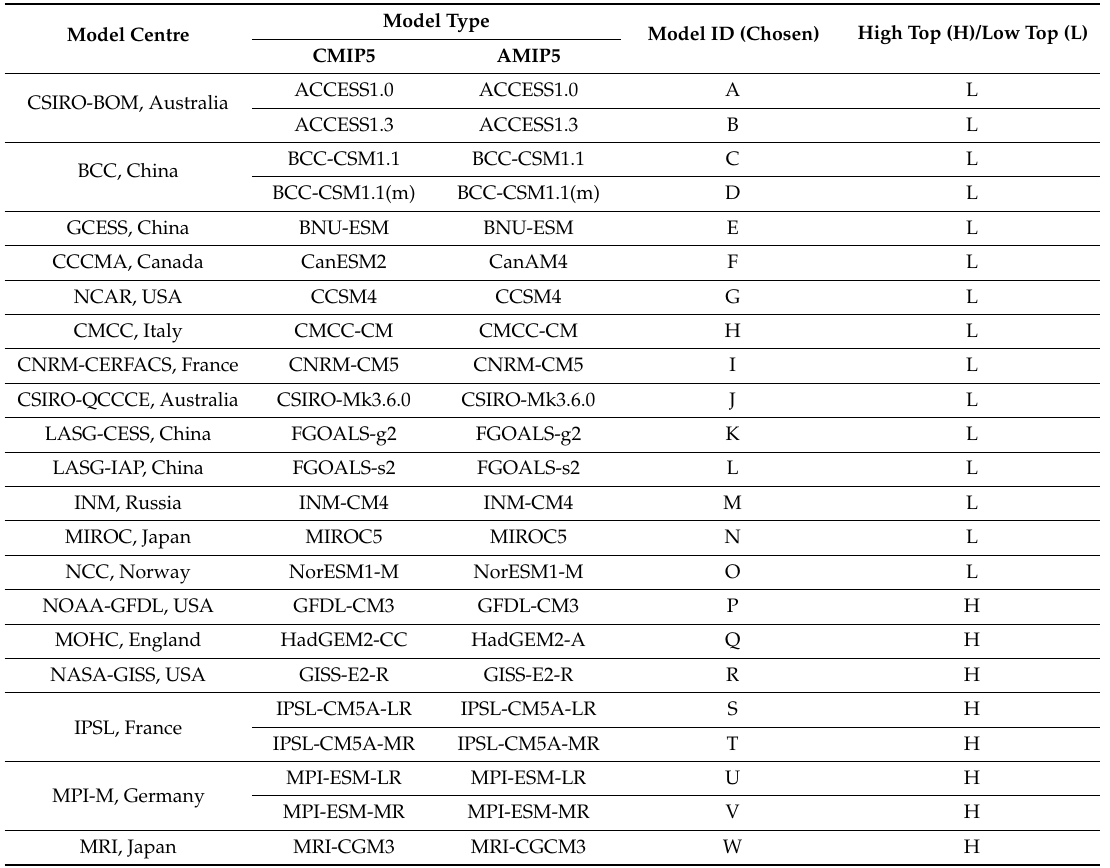
Table 1. Various modelling centres, with the name of the model types, CMIP5 and AMIP5. Models are separated as Low top (L) or High top